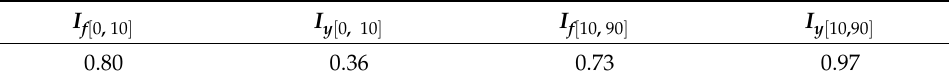
Figure 6. Graph of 𝑑 𝑡̃ (𝑡) .